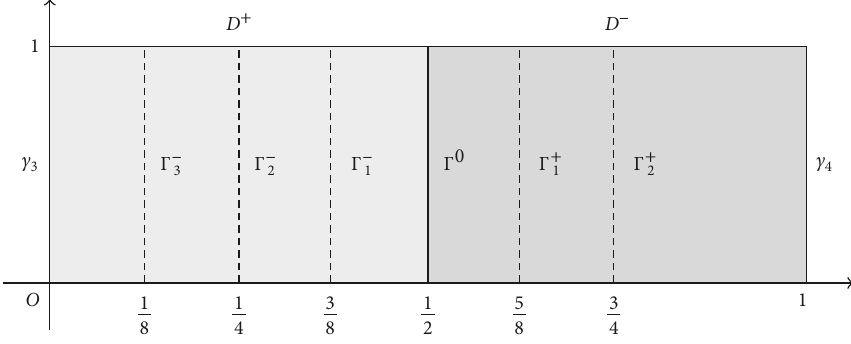
Figure 3: Domain for a numerical